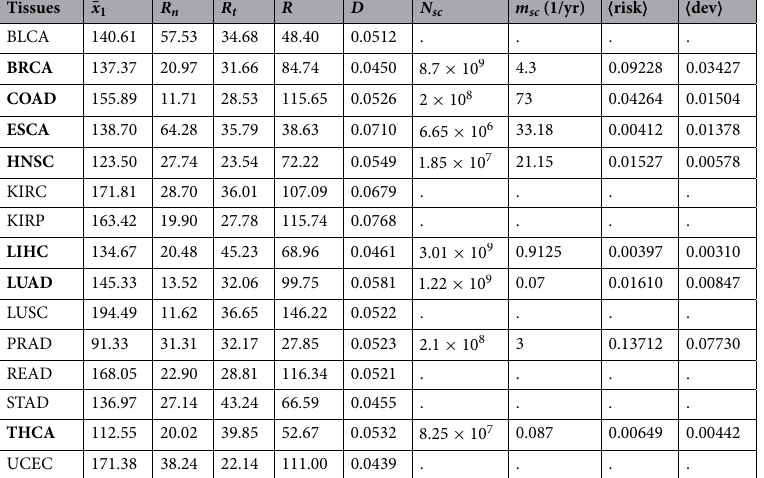
v 1 i 11 . On the other hand, the number of tissue | |